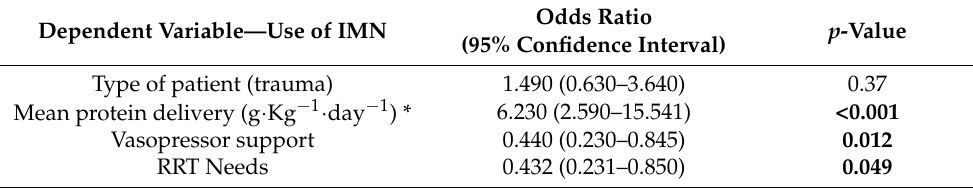
Figure 3. Kaplan–Meier curves and log rank test showing 28-day survival according to patients receiving immunonutrition or other types of enteral formulas. Table 4. Multivariate analysis—variables associated with the use of